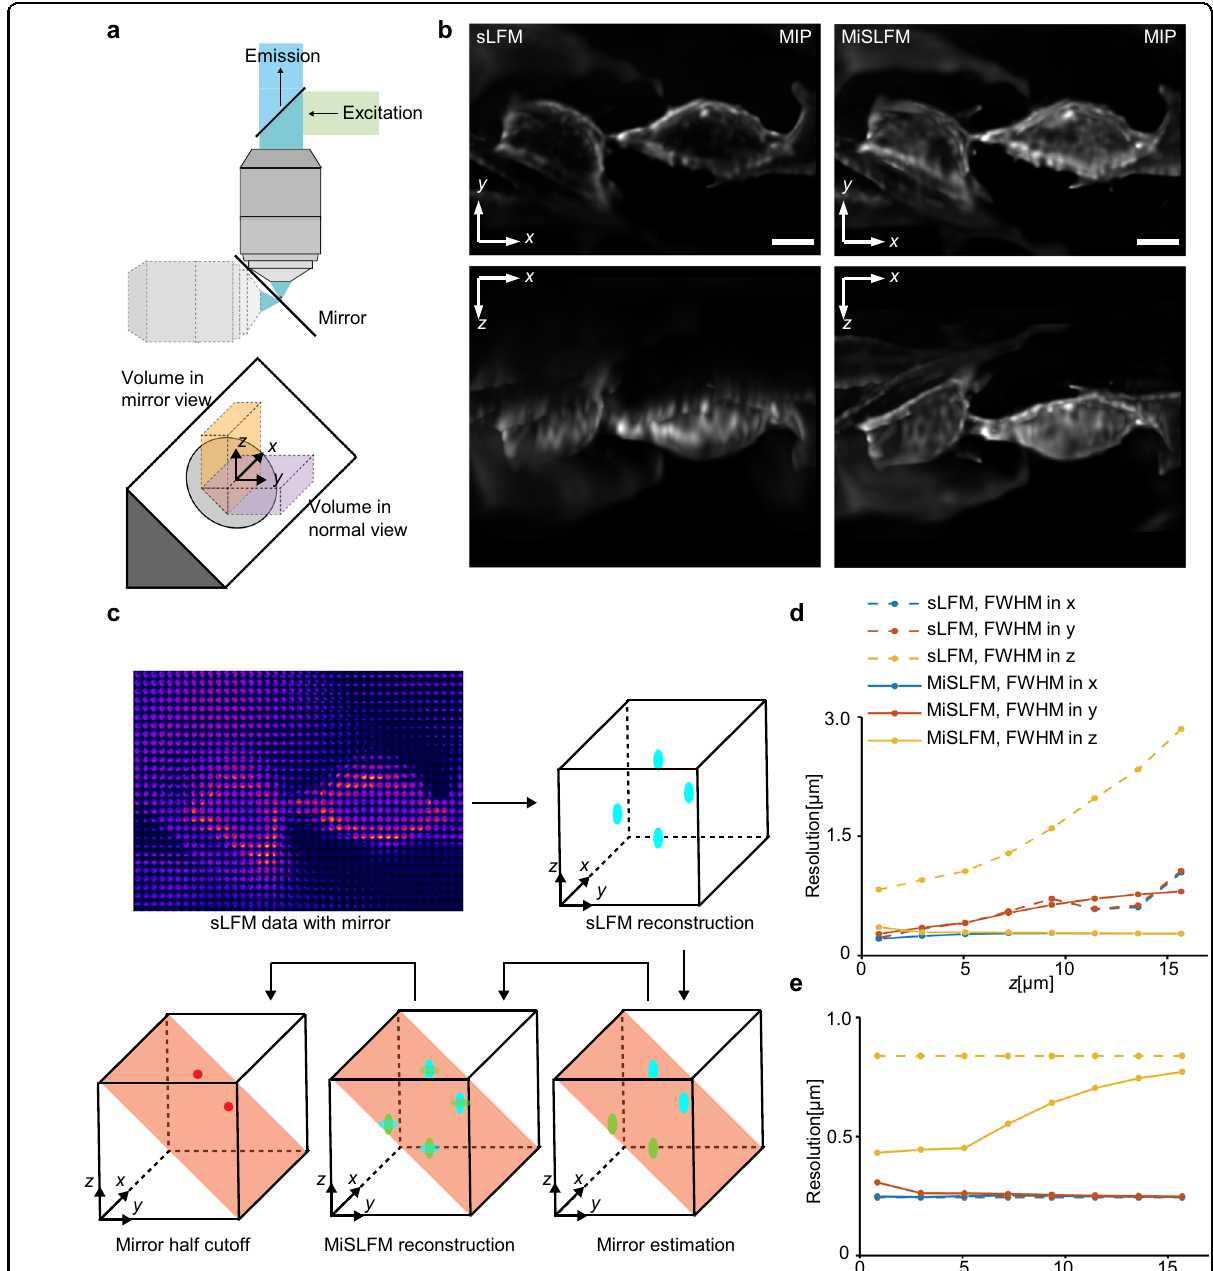
Fig. 1 Principles and evaluations of MiSLFM. a Objective and mirror con fi gurations of MiSLFM. The reference coordinate system on the mirror and a schematic of two light- fi eld volumes are shown in light yellow (volume in mirror view) and lavender (volume in normal view), and the overlapping volume indicates the isotropic resolution volume. b Maximum intensity projections (MIPs) of reconstructed cell membrane-stained L929 cells for sLFM and MiSLFM, demonstrating an obvious axial resolution improvement for MiSLFM. Scale bars, 10 μ m. c MiSLFM reconstruction pipeline. An initial 3D volume was reconstructed directly from the sLFM data including the mirror image, and a mirror estimation was applied to the volume. Then, the sLFM data were reconstructed again with the constraint of mirror symmetry, and only half of the volume was reserved. Coordinate systems in ( c ) are in concordance with the coordinate systems in ( a ). d , e Lateral and axial PSF FWHM for sLFM and MiSLFM estimated by simulations with a 40×/0.8NA objective along the z-axis and y-axis in the coordinate system of ( a ). MiSLFM improved the axial resolution across the entire overlapping volume and achieved a near-isotropic resolution of 0.4 μ m near the mirror. The axial resolution gradually dropped when the sample moved away from the mirror along the